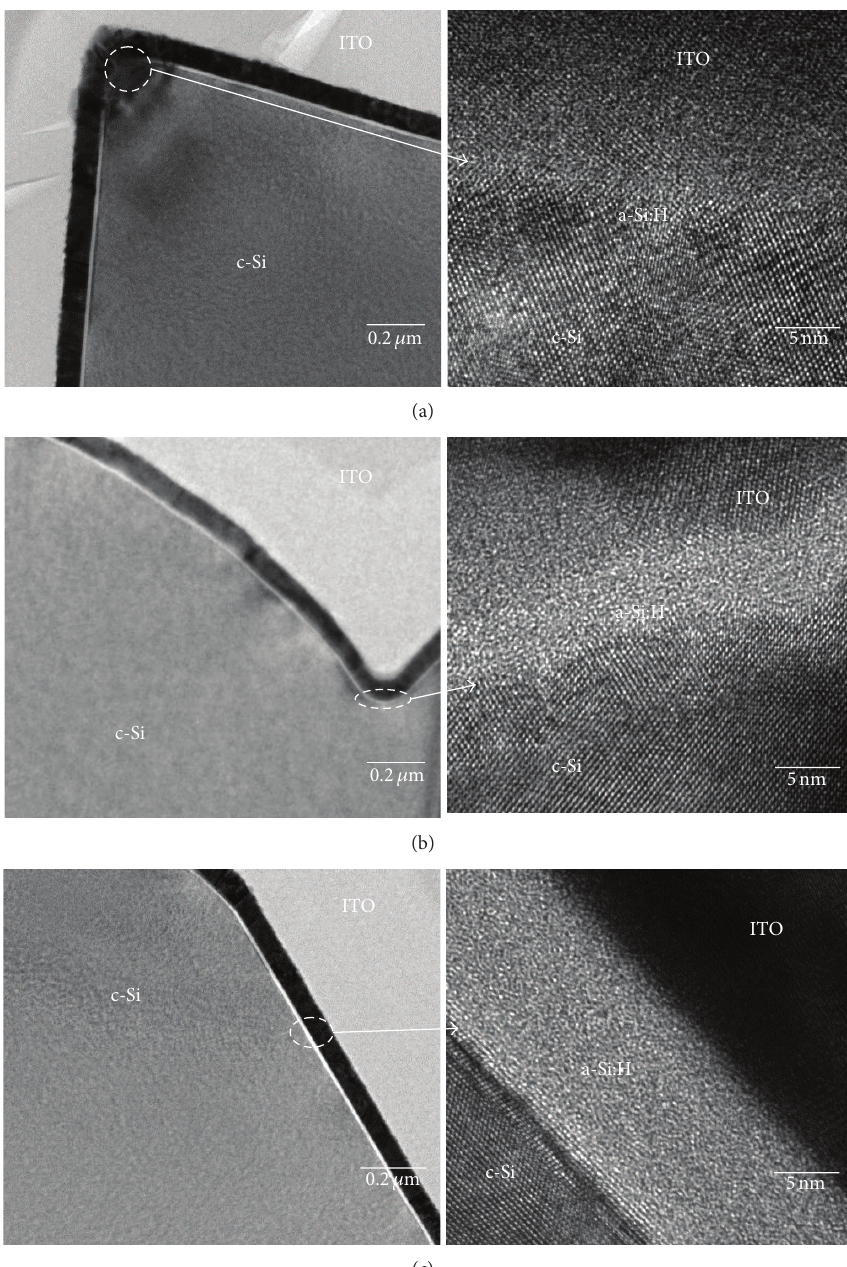
Figure 4: HRTEM cross-sectional micrographs of (a) peak, (b) valley, and (c) hillside of a pyramid of the 90 min etched wafer passivated by